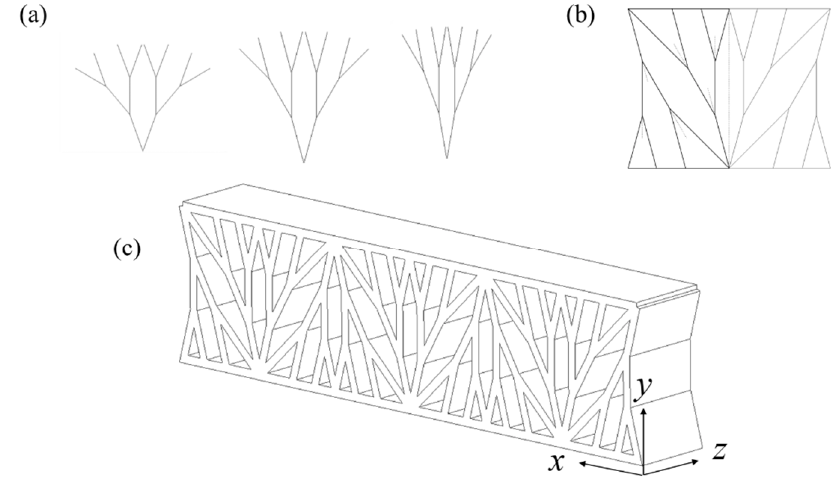
Figure 4. The evolution of bionic structures: ( a ) Three different fractal styles by Python programming; ( b ) Mirror representative volume element (RVE) model; ( c ) Array model of 15 degrees bionic structure.